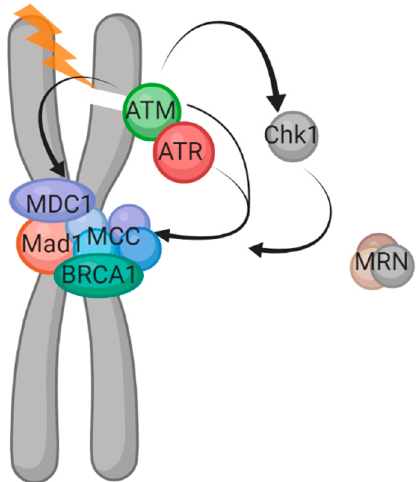
Figure 2. Summary of documented interplay between the DDR and SAC. DDR effectors ATM/ATR and downstream Chk1 have all been demonstrated as playing a role in SAC control, both in the unperturbed cell cycle and cells exposed to DNA damage.